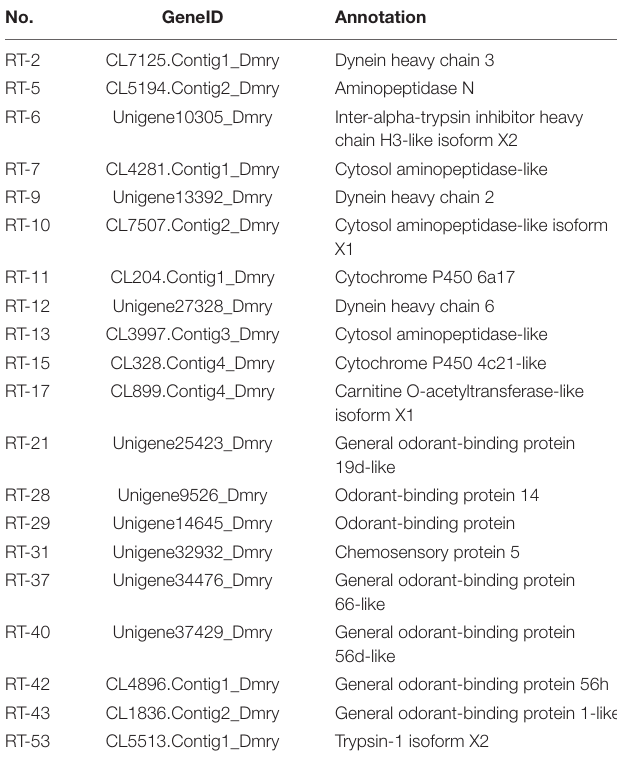
TABLE 1 | qRT-PCR verification of 20 differentially expressed